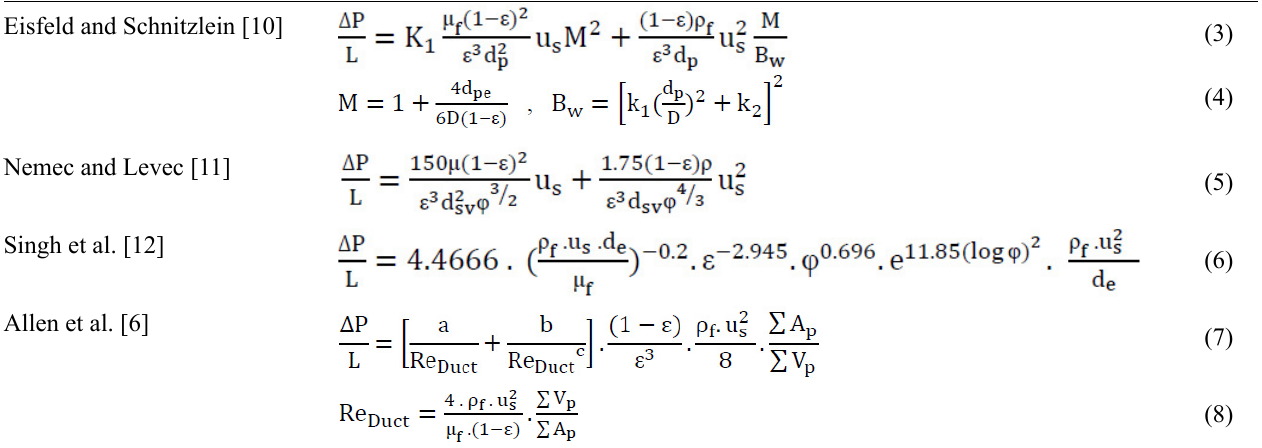
Table 1. Empirical correlations for calculating pressure drop with non-spherical particles.